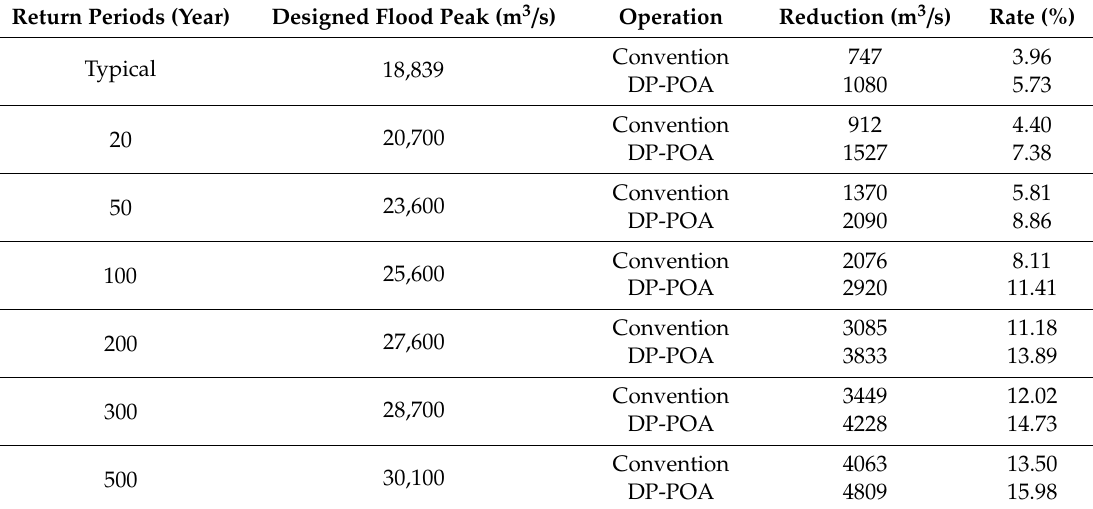
Table 9. Flood peak at the Waizhou flood control